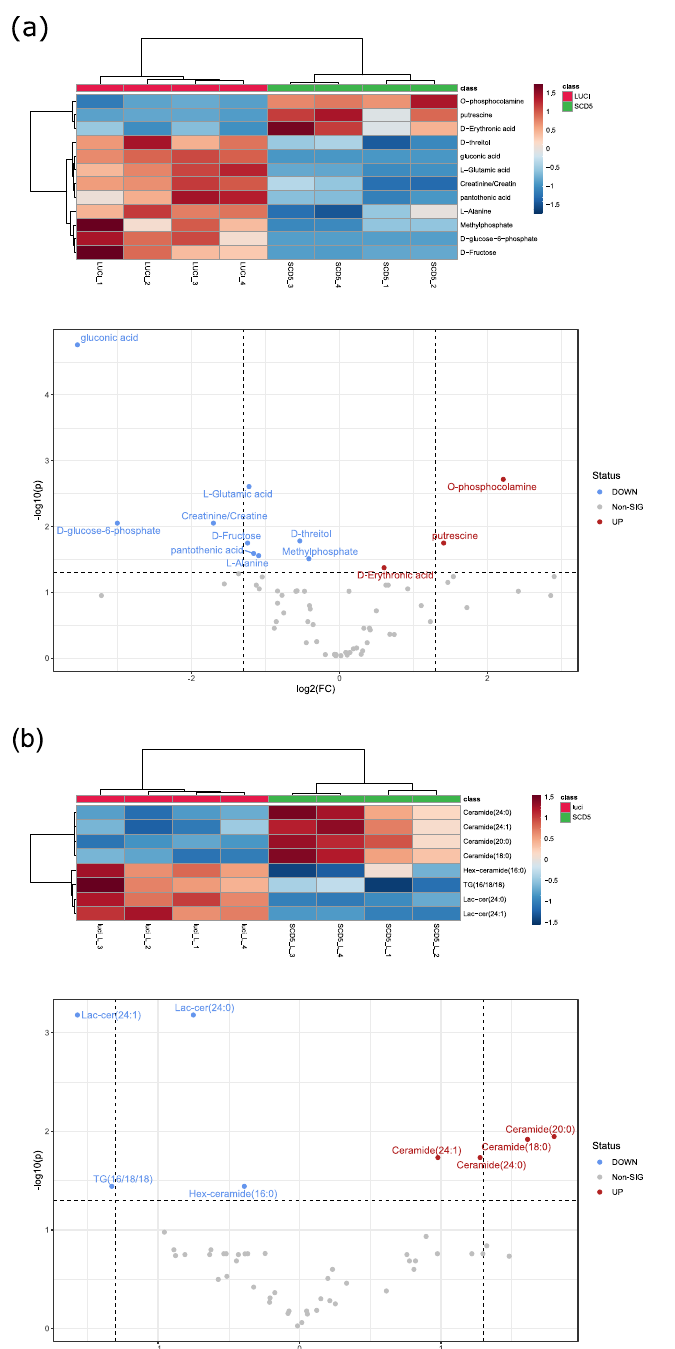
Figure 6. Metabolic and lipidomic assessment of ccRCC cells following SCD5 knockdown. ( a ) Heat map and volcano plot analysis of endometabolites in 786-O cells infected with control or SCD5 -specific shRNA. Only significantly altered metabolites (unpaired t -test, corrected for multi- ple testing) are displayed. Cluster analysis after Euclidian and Ward are displayed on top for samples, and on the left side for metabolites. Red: control 786-O cells. Green: SCD5 shRNA 786-O cells. Range scaled z-scores are displayed. n = four. ( b ) Heat map and volcano plot analysis of significantly altered lipids in 786-O cells infected with control or SCD5 -specific shRNA. Significance was determined by t -test. Cluster analysis after Euclidian and Ward revealed marked differences in SCD5 knockdown conditions. Red: control 786-O cells. Green: SCD5 shRNA 786-O cells. Range scaled z-scores are displayed. n =